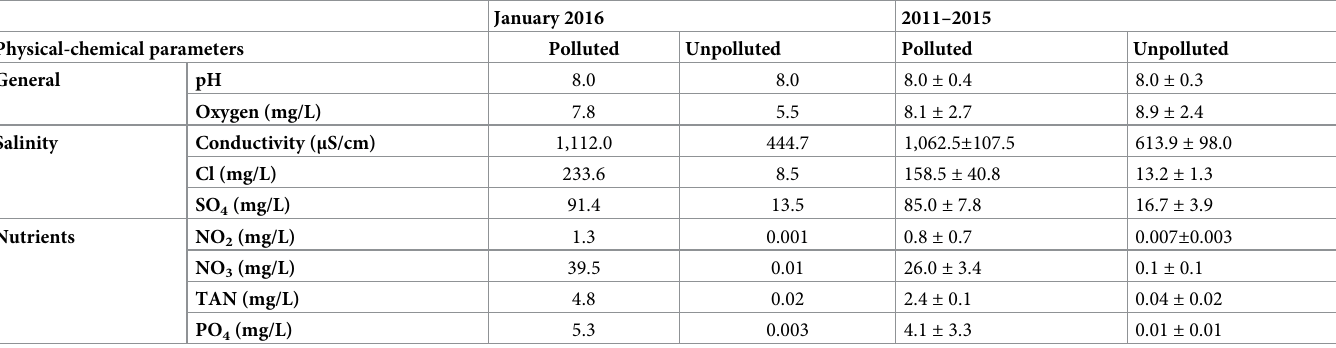
Table 1. Physical-chemical water parameters from polluted and unpolluted sites.